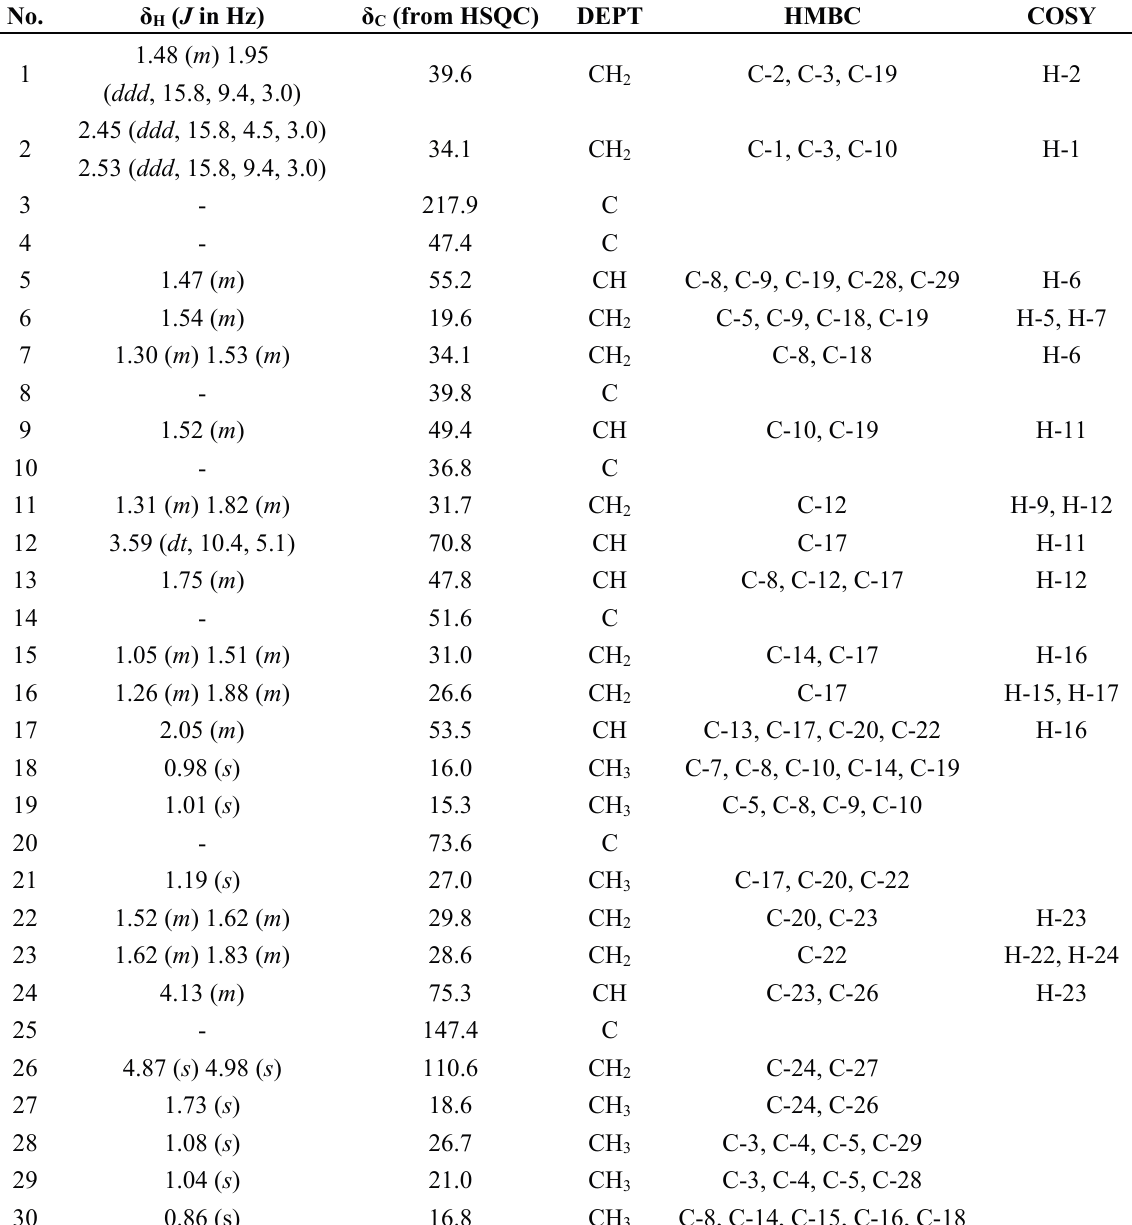
Figure 3. Δδ values ( δ S – δ R ) obtained from ( S )- and ( R )-Mosher esters of compound 6 . Table 1. 1D- and 2D-NMR data of 6 in CDCl 3 ( δ in ppm, J in